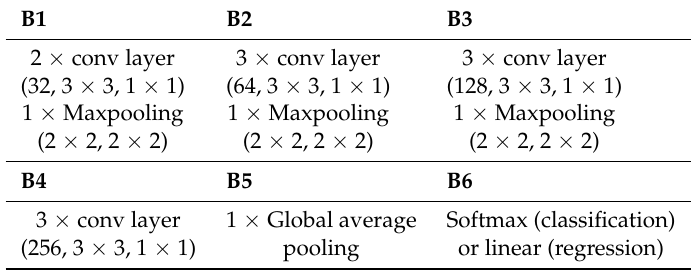
Table 1. Details of parameters in proposed network. Notions(channels, kernel, stride) and (kernel, stride) are used to define the conv and pooling